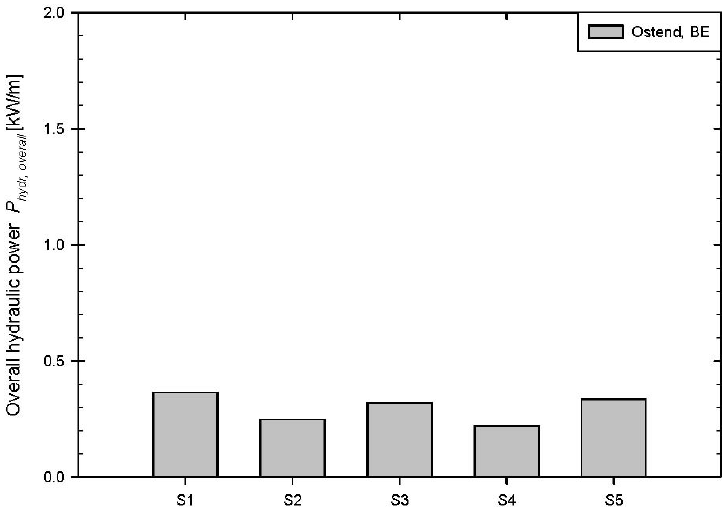
Figure 10. Comparison between effects of five scenarios on the overall hydraulic power for test site in Ostend, Belgian Continental